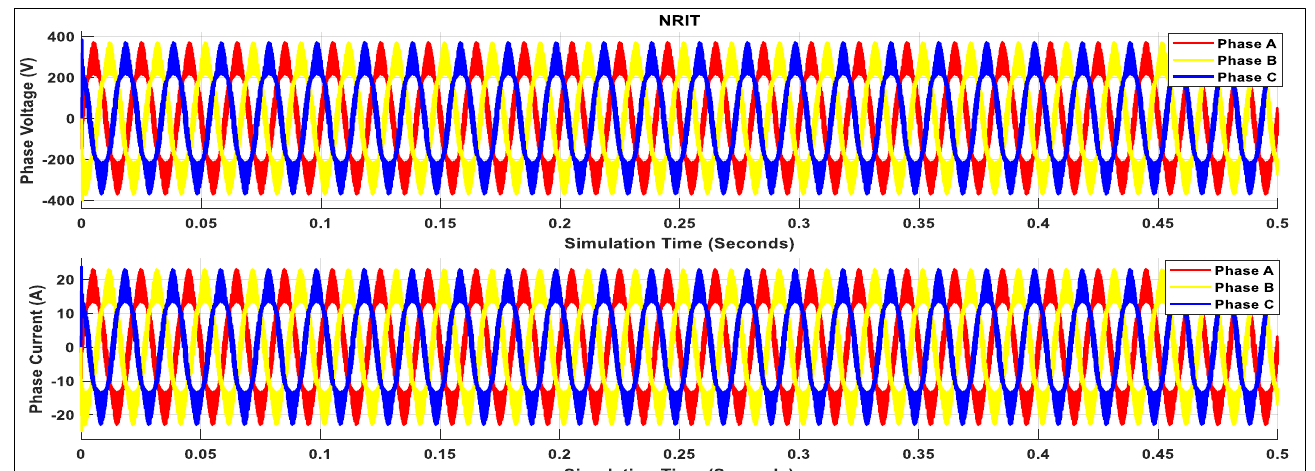
Figure 17. The THD case study 2 performance results with ICLS-DSOGI-PLL.